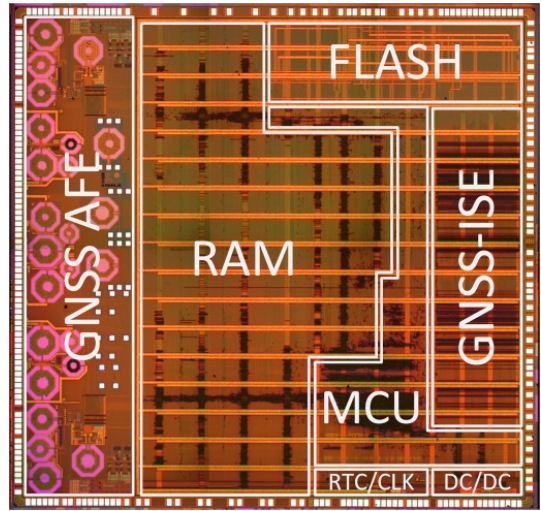
Figure 14. Microphotograph of CCNV1-A1, integrated multi-constellation, and multi-frequency GNSS receiver.